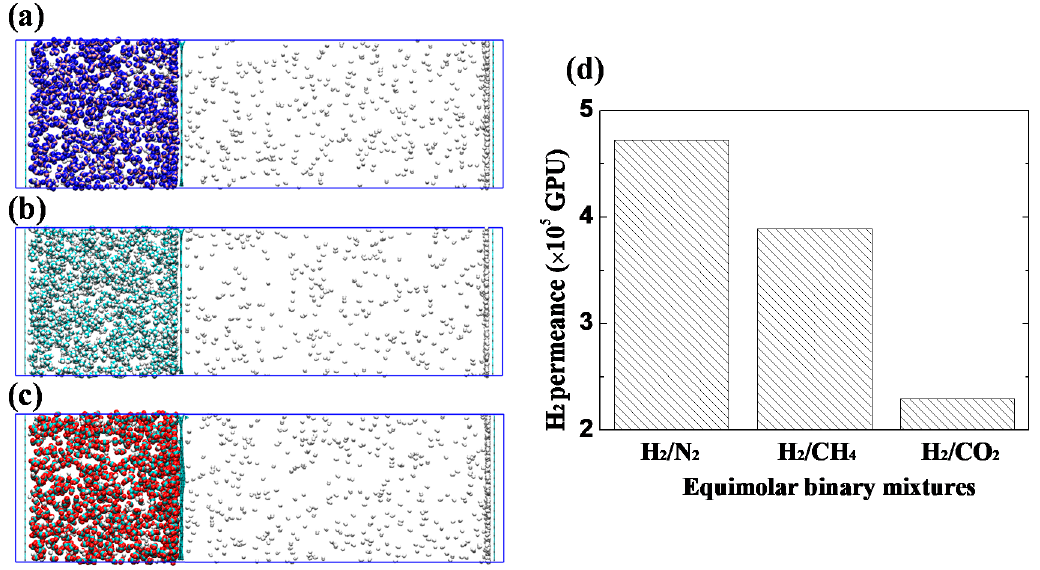
Figure 5. H 2 permeation of three equimolar binary mixtures crossing the GDY_2.1Å. The final snapshots: ( a ) H 2 /N 2 , ( b ) H 2 /CH 4 , and ( c ) H 2 /CO 2 . Blue: N; cyan: C; red: O; white: H. ( d ) The H 2 permeance of different binary mixtures.